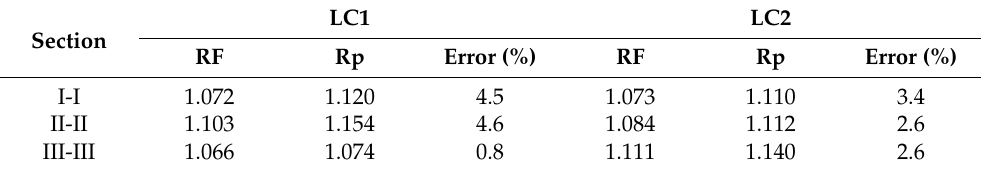
Figure 12. Strain comparison in SU-LRSCS: ( a ) I-I section (LC1); ( b ) II-II section (LC1); ( c ) III-III section (LC1); ( d ) I-I section (LC2); ( e ) II-II section (LC2); ( f ) III-III section (LC2).